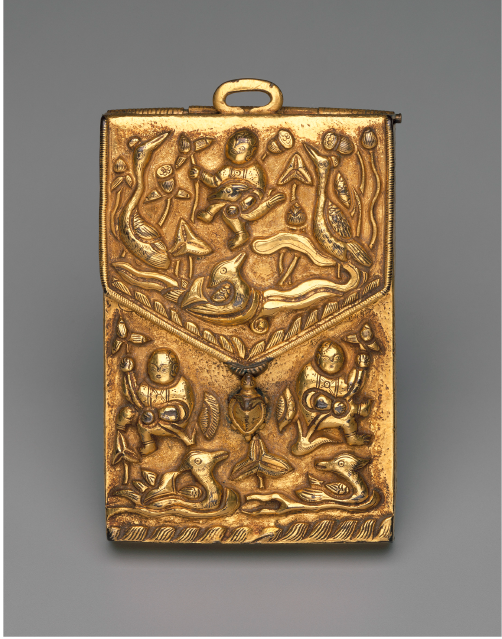
Figure 17. Sutra case. Koryŏ dynasty, twelfth to thirteenth century. L. 9.0 cm, w. 6.1 cm, d. 2.1 cm. Museum of Fine Arts, Boston. Charles Bain Hoyt Fund, 67.1. Photograph © [2023] Museum of Fine Arts, Boston.